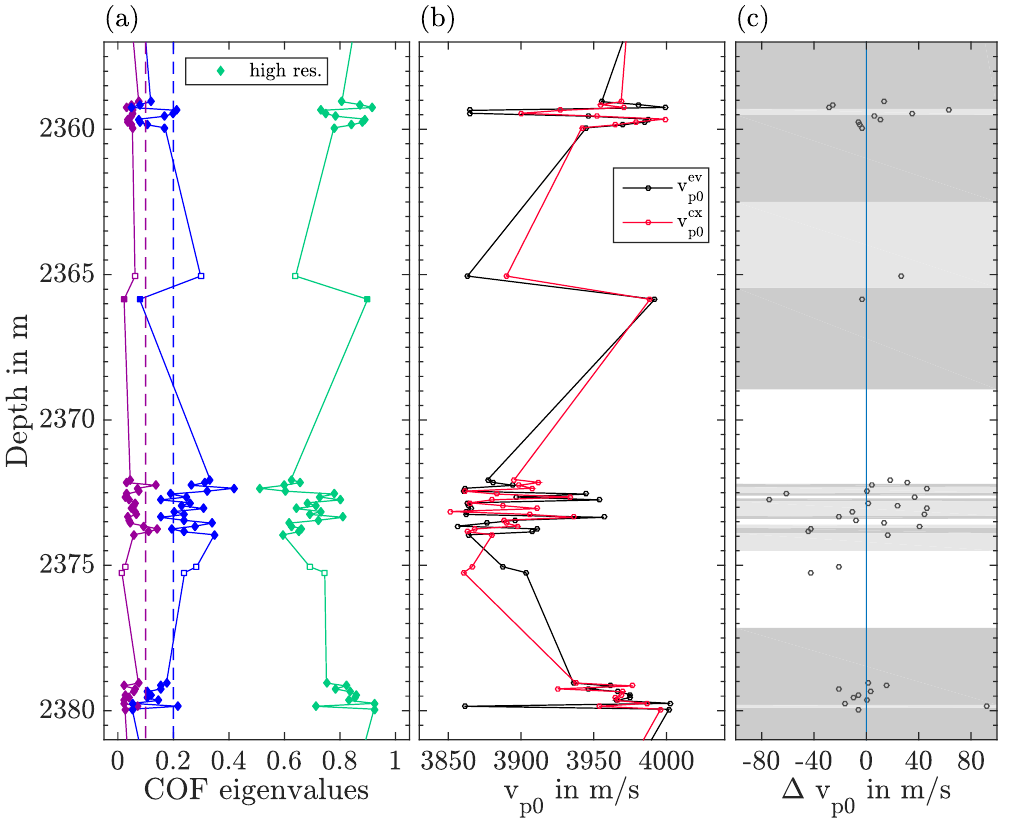
Figure 5. Comparison of P-wave velocities at vertical incidence, calculated from EDML fabric data measured at high resolution (vertical sections) between 2358 and 2380m depth with the fabric analyser G50. The same variables as in Fig. 4a–c are shown: (a) eigenvalues, with the same symbols as defined in Fig. 4 and (b) calculated interval P-wave velocity for vertical incidence. (c) The velocity difference between frameworks and fabric classes are indicated by shading (dark grey: cone, light grey: thick girdle, white: partial